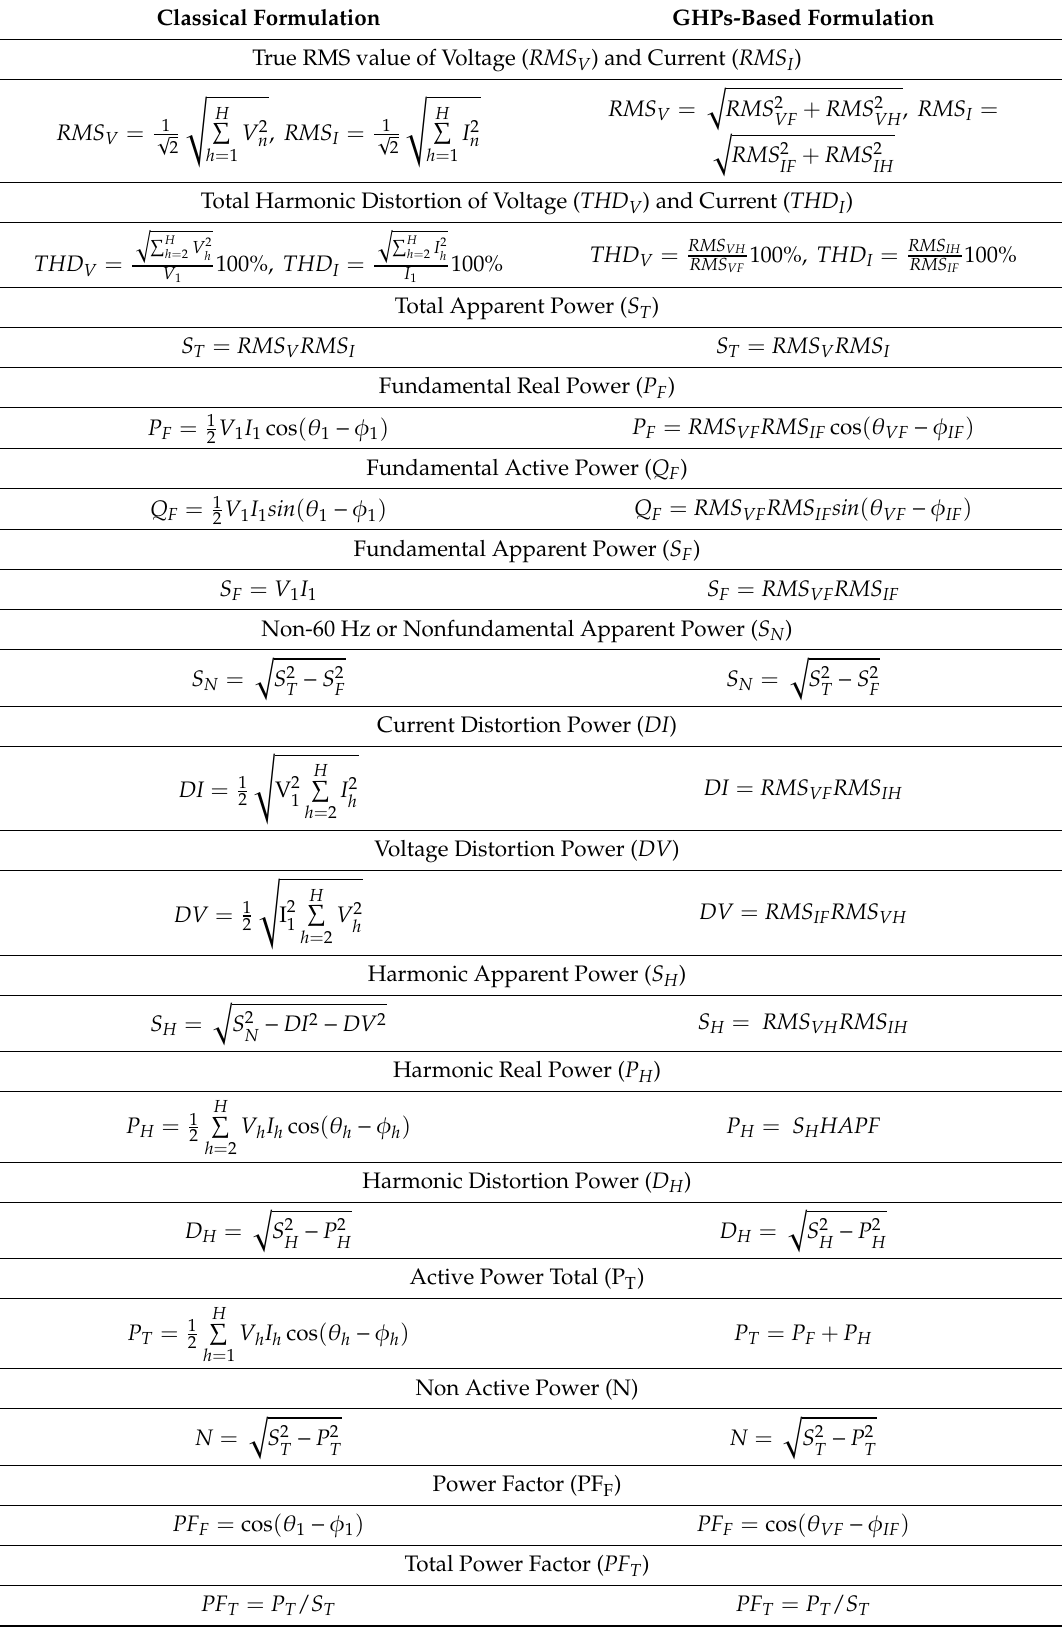
Table 1. Equations for power quality indices